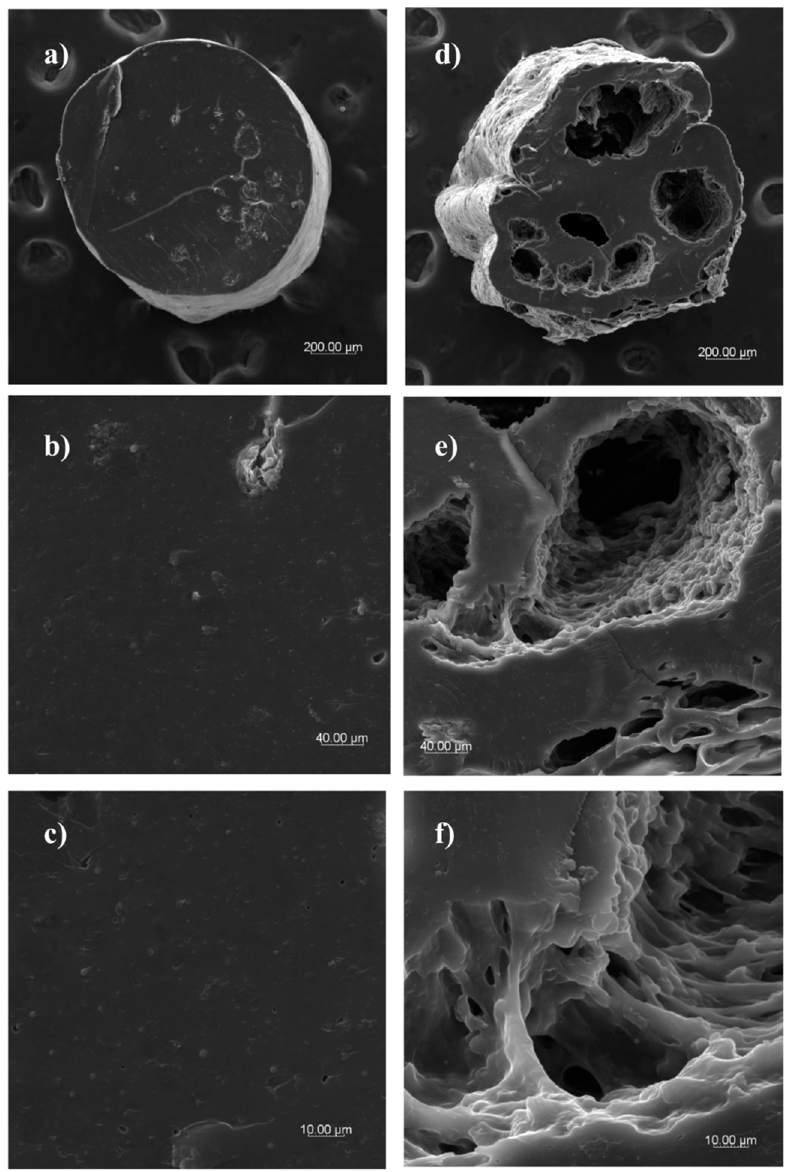
Figure 5. Cross-section of dry ( a – c ) and hydrated ( d – f ) rice-buckwheat pasta (magnification 100 × , 600 × , 2000 × , respectively).